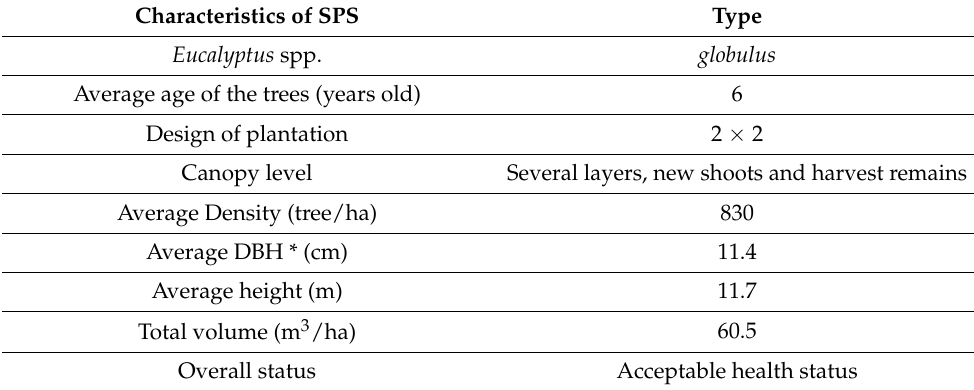
Table 1. Main characteristics of the Silvopastoral Systems (SPS) under study. Characteristics of SPS